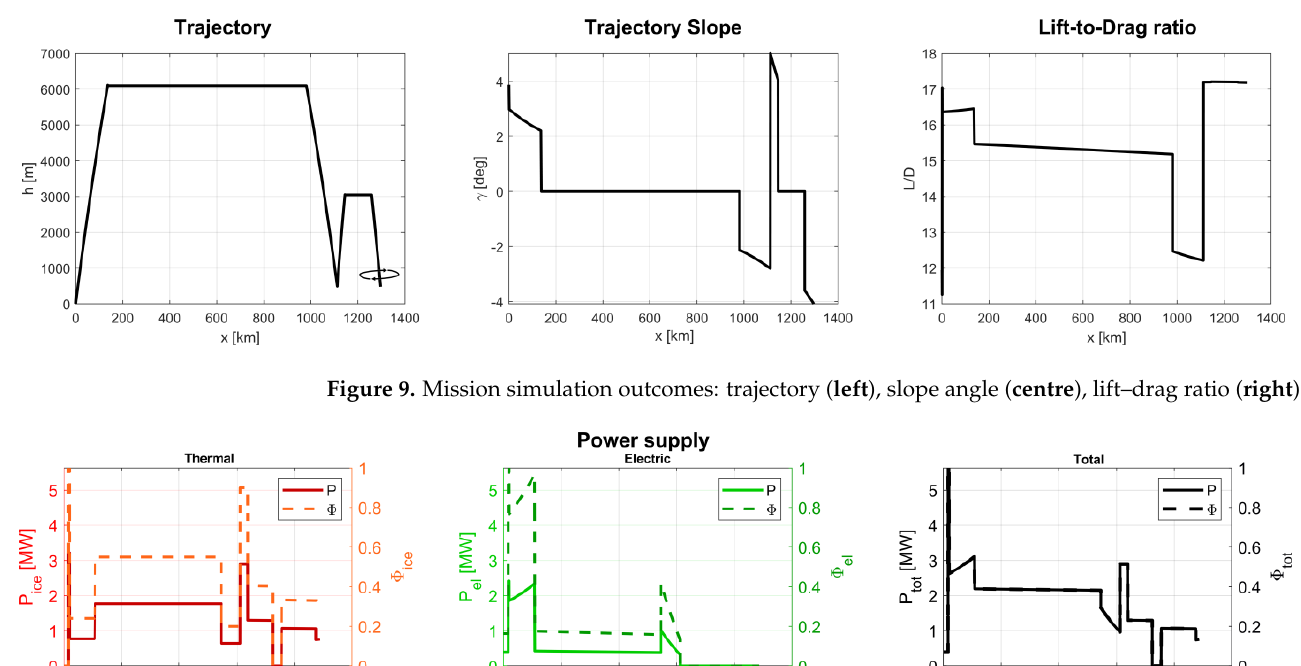
Figure 8. Planform of the hybrid-electric regional aircraft.